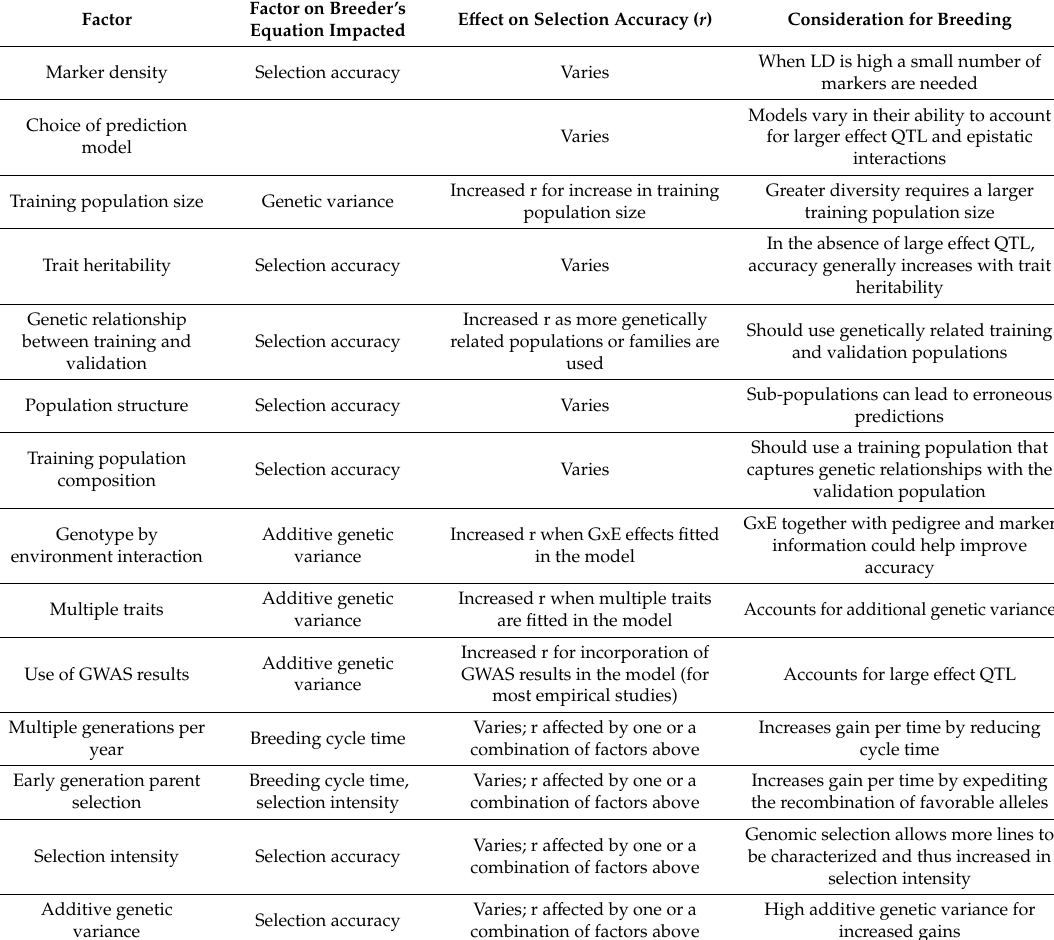
Table 1. Modifications to genomic selection and impact on the breeder equation and accuracy. Factor on Breeder’s E ff ect on Selection Accuracy ( r ) Consideration for Factor Equation Impacted